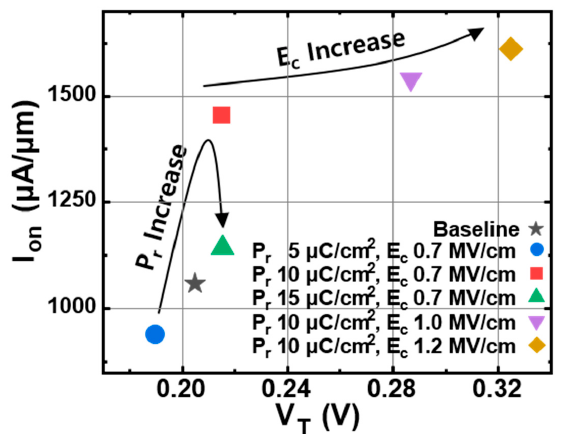
Figure 4. V INT -vs.-time for a few E c ( a ) and P r ( b ). The black-colored dotted reference line indicates the 100 MHz 1 V triangular pulse. The estimated drain current-vs.-gate voltage (I D -vs.-V G ) of baseline FinFET (see the black-colored solid line) and MFMIS NC FinFET (see the blue/red/purple-colored solid lines) for a few E c ( c ) and P r ( d ). Figure 5. Scatter plot of extracted I ON and V T of various MFMIS NC FinFETs.